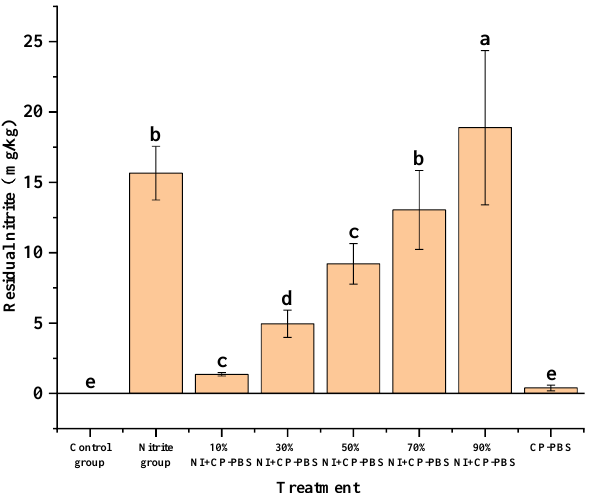
Figure 2. Effect of different treatments on residual nitrite in the smoked sausages. a~e Mean values in the same row followed by different letters are significantly different ( p < 0.05).